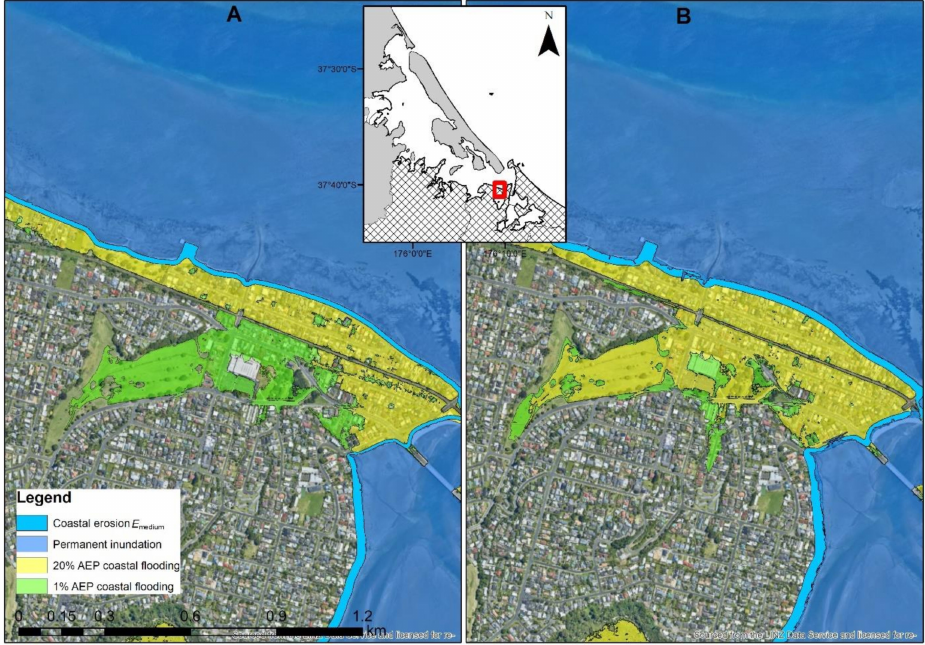
Figure 7. Comparison of hazard exposure extent for an area within Tauranga Harbour: ( A ) RSLR = 0.4 m, ( B ) RSLR = 0.6